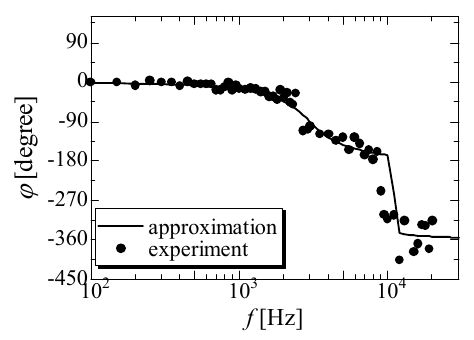
Fig. 5 Phase difference ϕ vs. frequency f .